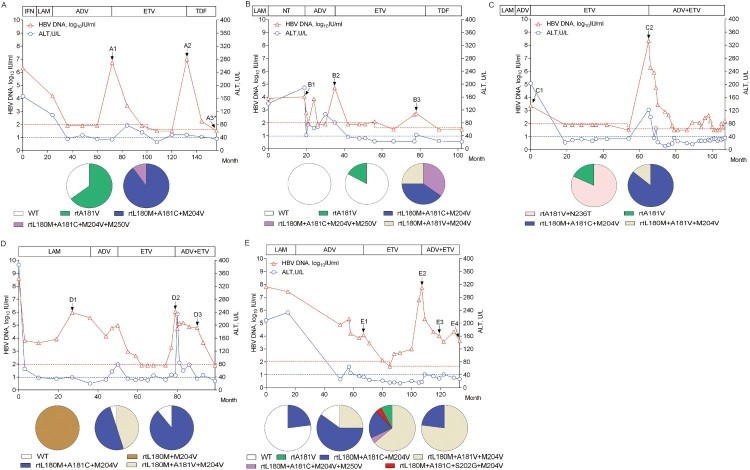
The evolution of drug-resistance HBV and clinical responses during the antiviral therapies for representative patients (n = 5). The dynamic changes of serum HBV DNA and alanine aminotransferase (ALT) levels are shown along with the antiviral therapies. The durations (months) of the antiviral therapies is indicated by the bars above the graph and serum samples from the patient are indicated by the sample (A−E) numbers below the graph. Two dashed lines show the lower detection limit of HBV DNA in two successive periods in clinic (100, 40 IU/mL) and normal ALT level (40 U/L). Proportions of wild-type (WT) and mutant HBV strains in the viral reverse transcriptase from each sample are depicted by a series of pie charts. IFN: interferon-α; LAM: lamivudine; ADV: adefovir dipivoxil; ETV: entecavir; and TDF: tenofovir disoproxil fumarate. NT: not treated with antivirals.